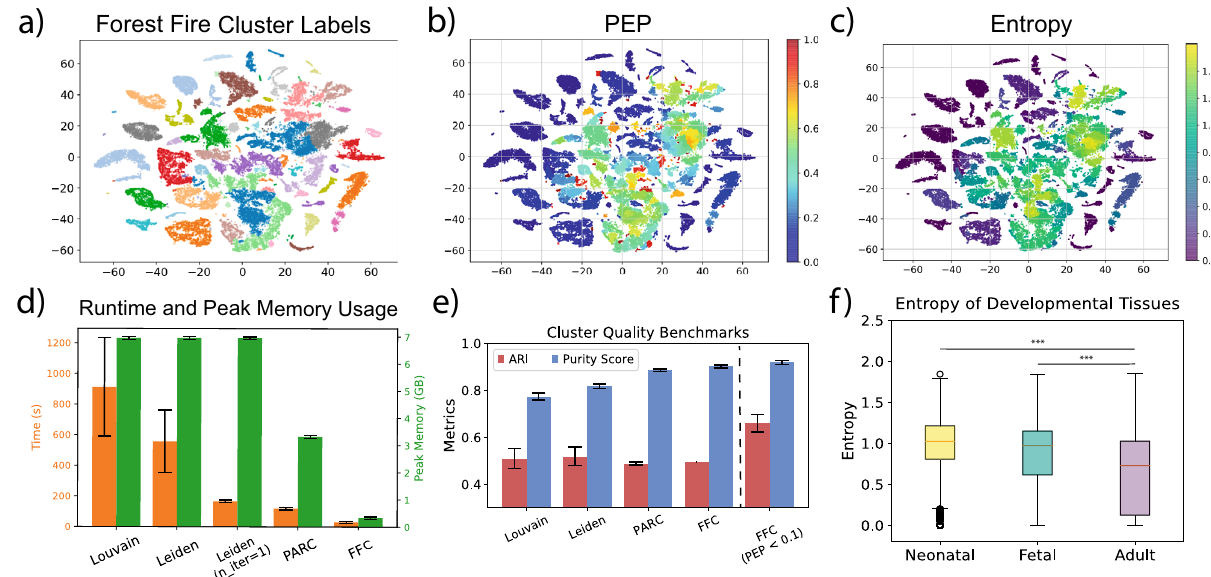
Fig. 6 Benchmarking Forest Fire Clustering on MCA data. a Forest Fire cluster labels. b Posterior exclusion probability for the Forest Fire cluster labels. c Entropy for the Forest Fire cluster labels. d Clustering runtime and peak memory usage benchmarks ( n = 20 different seeds). e Clustering quality benchmarks ( n = 20 different seeds). Note that cells with high-con fi dence labels (PEP < 0.1) from the internal validation signi fi cantly improved the clustering quality. Data are presented as mean values + / − 2SD. f Label entropy at different developmental stages. The box plot visualizes data based on the minimum, fi rst quartile or 25 percentile as lower box bound, median as center, third quartile or 75 percentile as higher box bound, and maximum. *** denotes two-sided Mann – Whitney U tests with P < 1 × 10 − 3